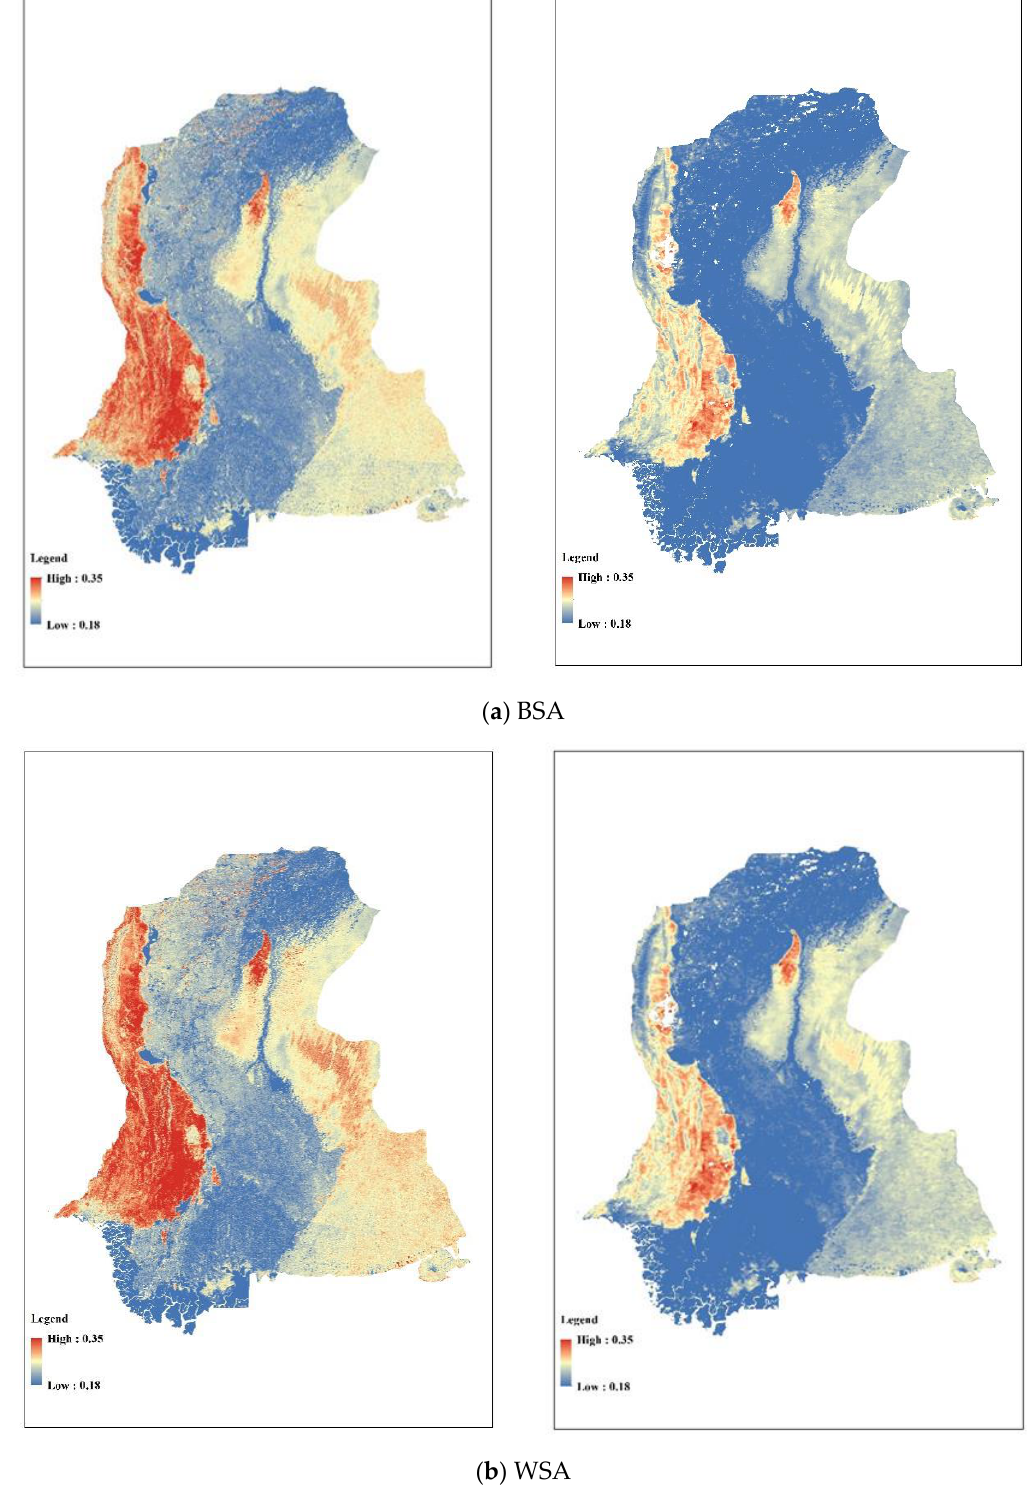
Figure 10. Comparison of the ( a ) black-sky albedo and ( b ) white-sky albedo of the GF-1 (left) and MODIS (right) in Sindh.